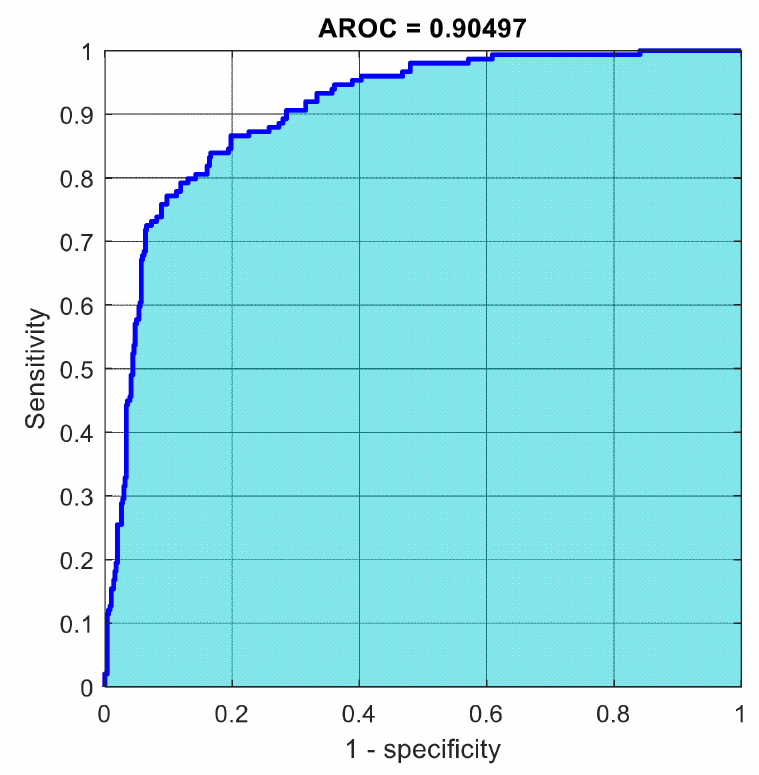
Figure 25. The AROC for cascading model using 1000 deep learning features.